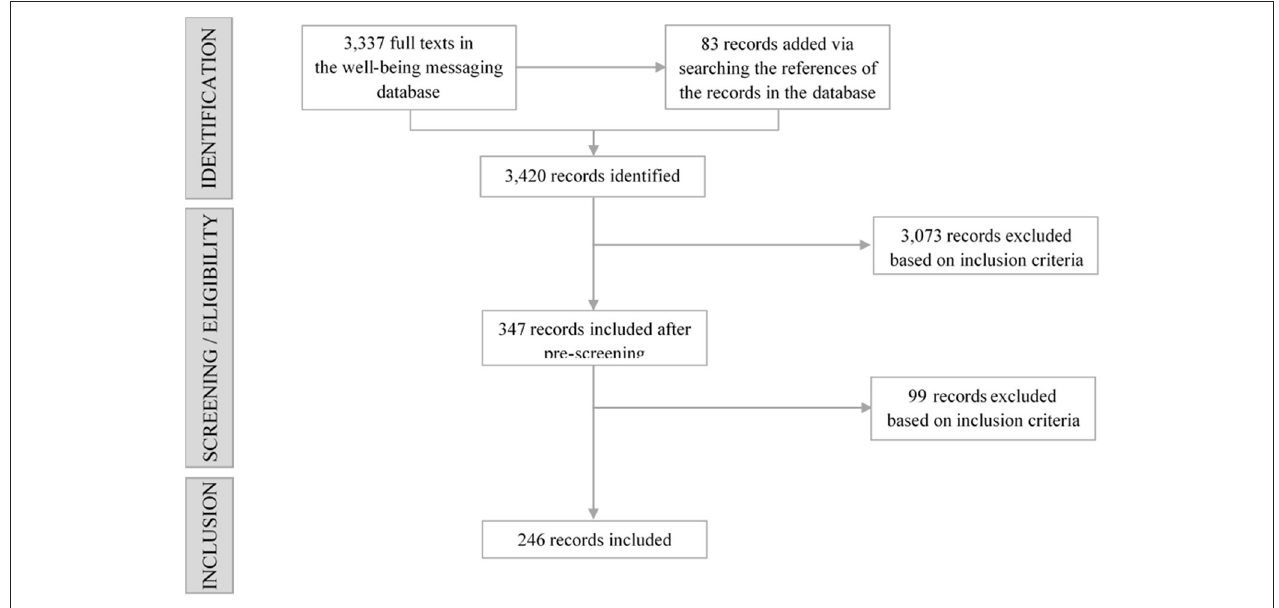
FIGURE 1 | A search flowchart resulting in the final 246 records included in this review.